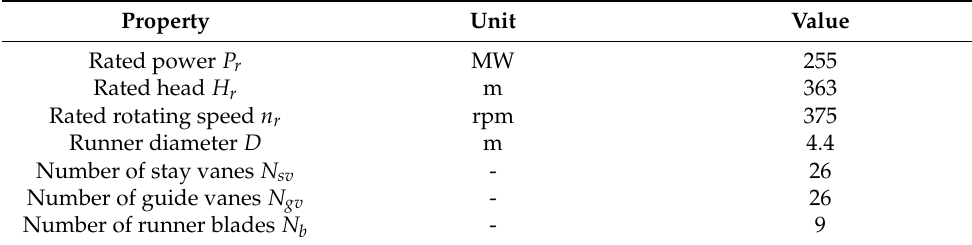
Figure 1. The structural and fluid model of the investigated pump turbine. Table 1. Basic parameters of the pump-turbine unit.